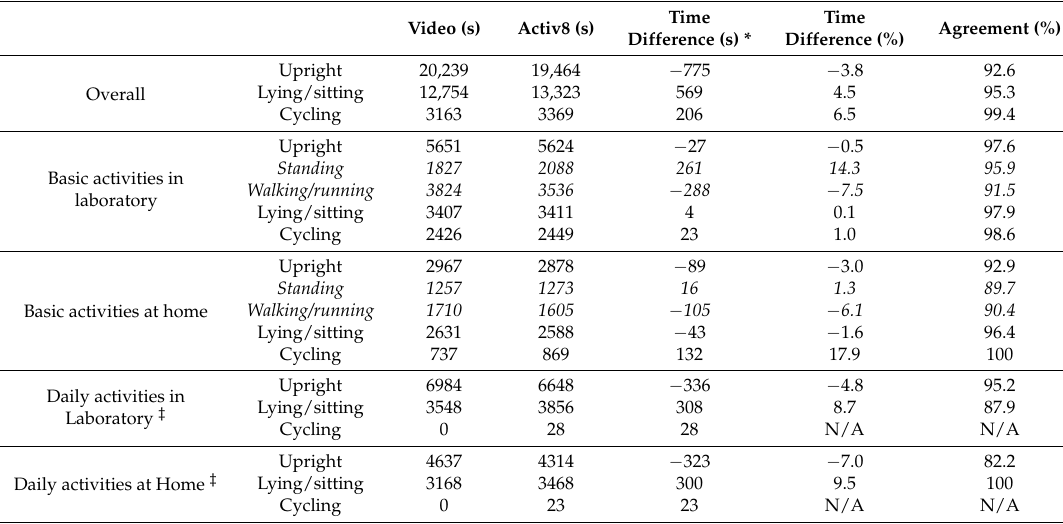
Table 2. The video data, Activ8 output, time difference (absolute in seconds and as a percentage), and agreement (overall and per